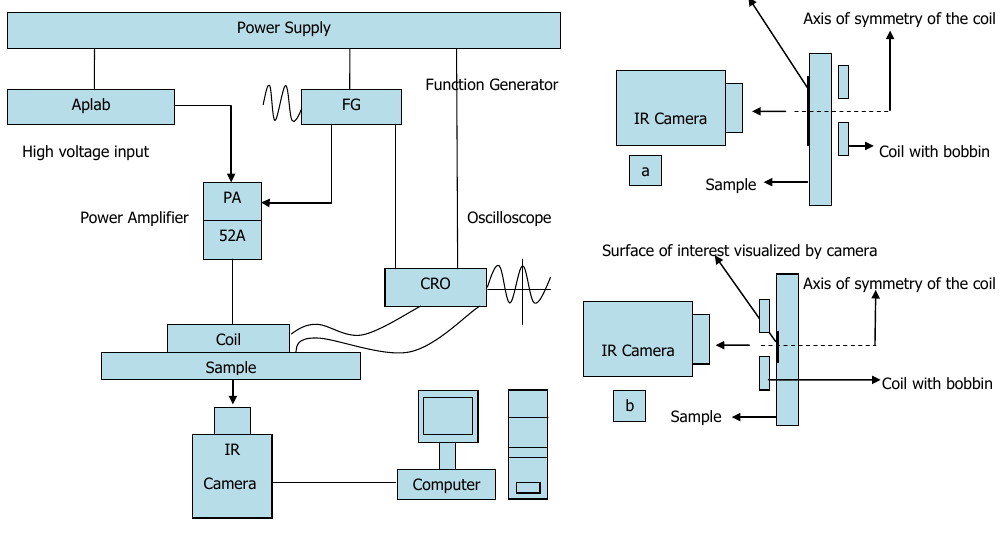
Figure 2. The experimental apparatus of tone burst eddy current thermography (TBET) in schematic format on the left and the two modes of data collection, i.e. , transmission and reflection, on the right-hand